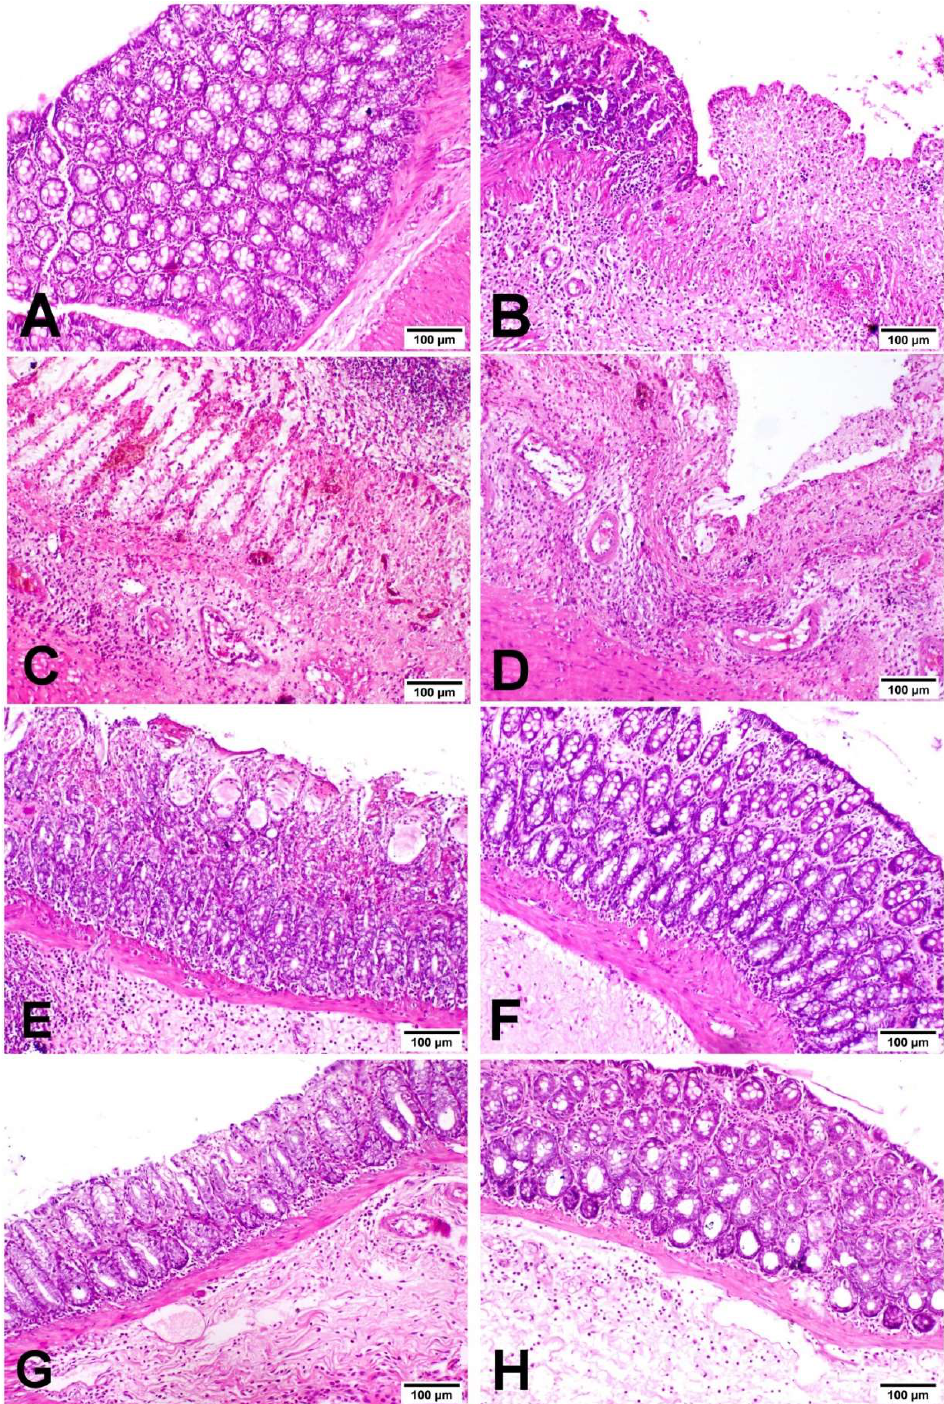
Figure 3. Photomicrograph of colons of different groups stained with H&E stain. ( A ) NC group showing a normal histological finding of the colon. ( B ) UC group showing area of ulcerative colitis with complete destruction of the colon mucosa. ( C ) UC group showing complete crypt necrosis, inflammatory cell infiltration in the mucosa and submucosa and congestion of blood vessels. ( D ) UC group showing complete necrosis of the mucosa with submucosal fibrous connective tissue proliferation with mononuclear inflammatory cell aggregation. ( E ) MIC-20 showing necrosis of some crypts with a moderate inflammatory reaction in the mucosa and submucosa. ( F ) MIC-40, ( G ) SSZ-100 and ( H ) MIC + SSZ groups showing minimal inflammatory reaction in the mucosa and submucosal